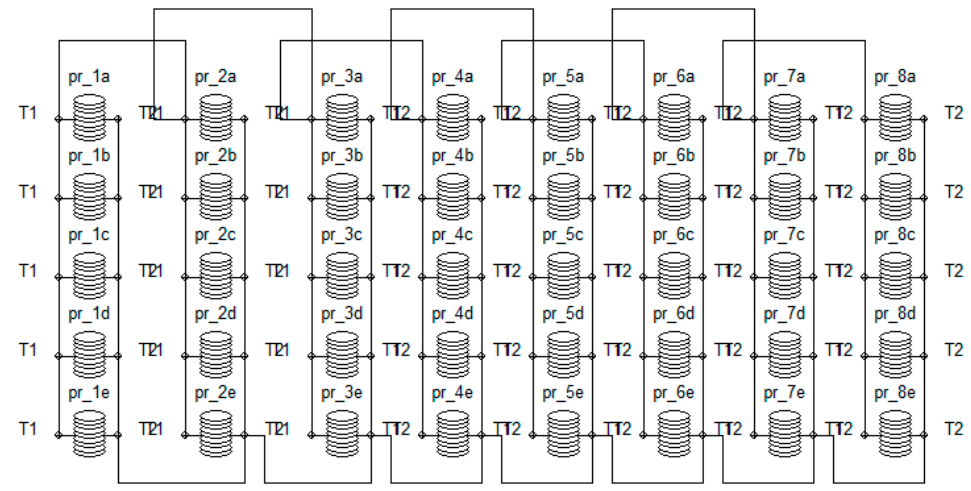
Figure 4. Damper winding connection.